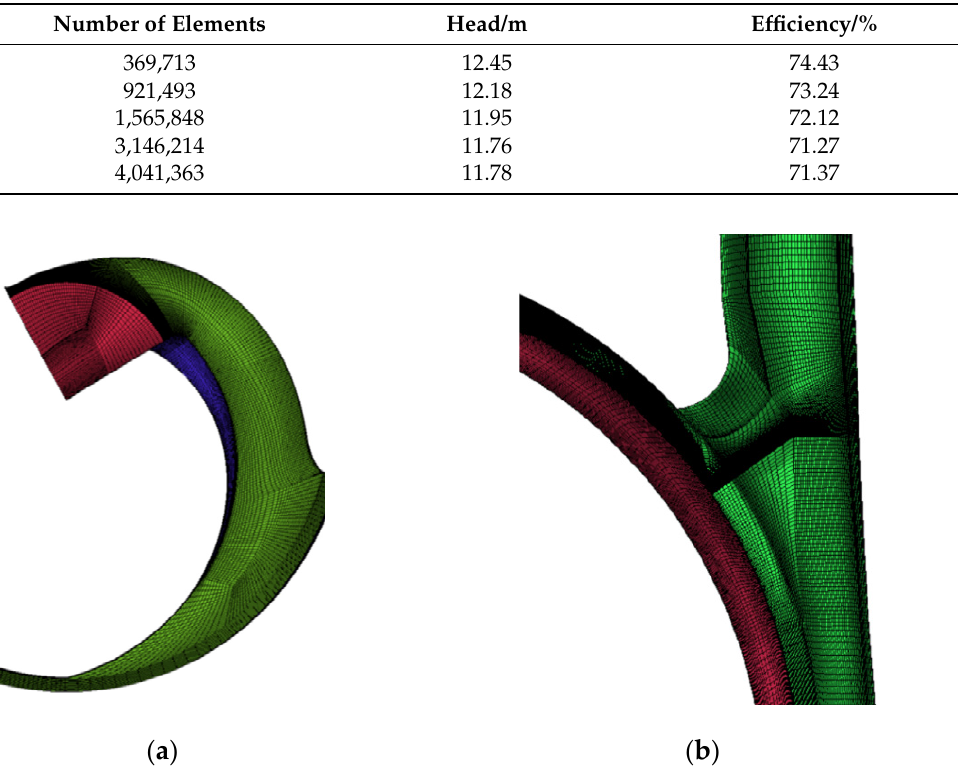
Table 2. Grid independence analysis.